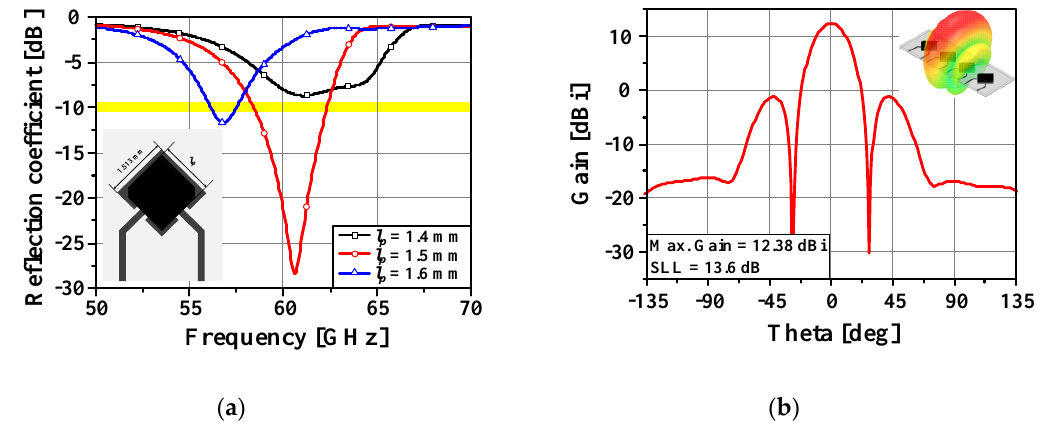
Figure 10. ( a ) Simulated reflection coefficient for various length of the parasitic stacked patch. ( b ) Simulated gain pattern of the patch antenna array.